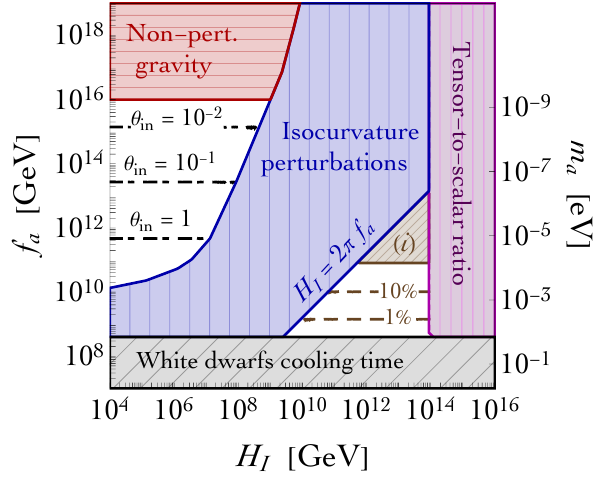
Figure 6 . QCD axion parameter space (see text for details). The region shaded in red with horizontal meshes is excluded by non-perturbative gravitational e(cid:11)ects, eq. (6.4). Note that the ticks on the right y-axis follow the relation between m a and f a dictated by QCD that ceases to be valid when non-perturbative gravitational e(cid:11)ects become